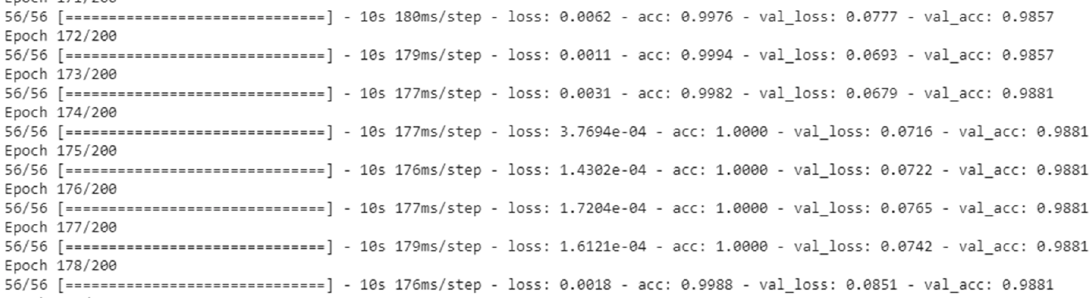
Figure 6. Showing ResNet101 training process using fine-tuning .